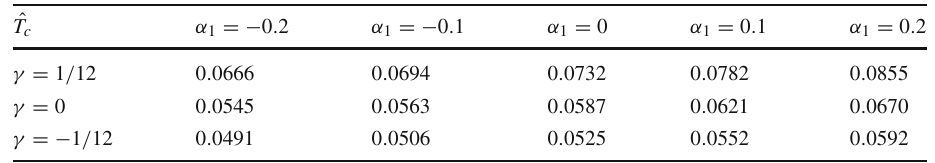
temperature ˆ T c with different α 1 and γ . Here γ 1 = 0